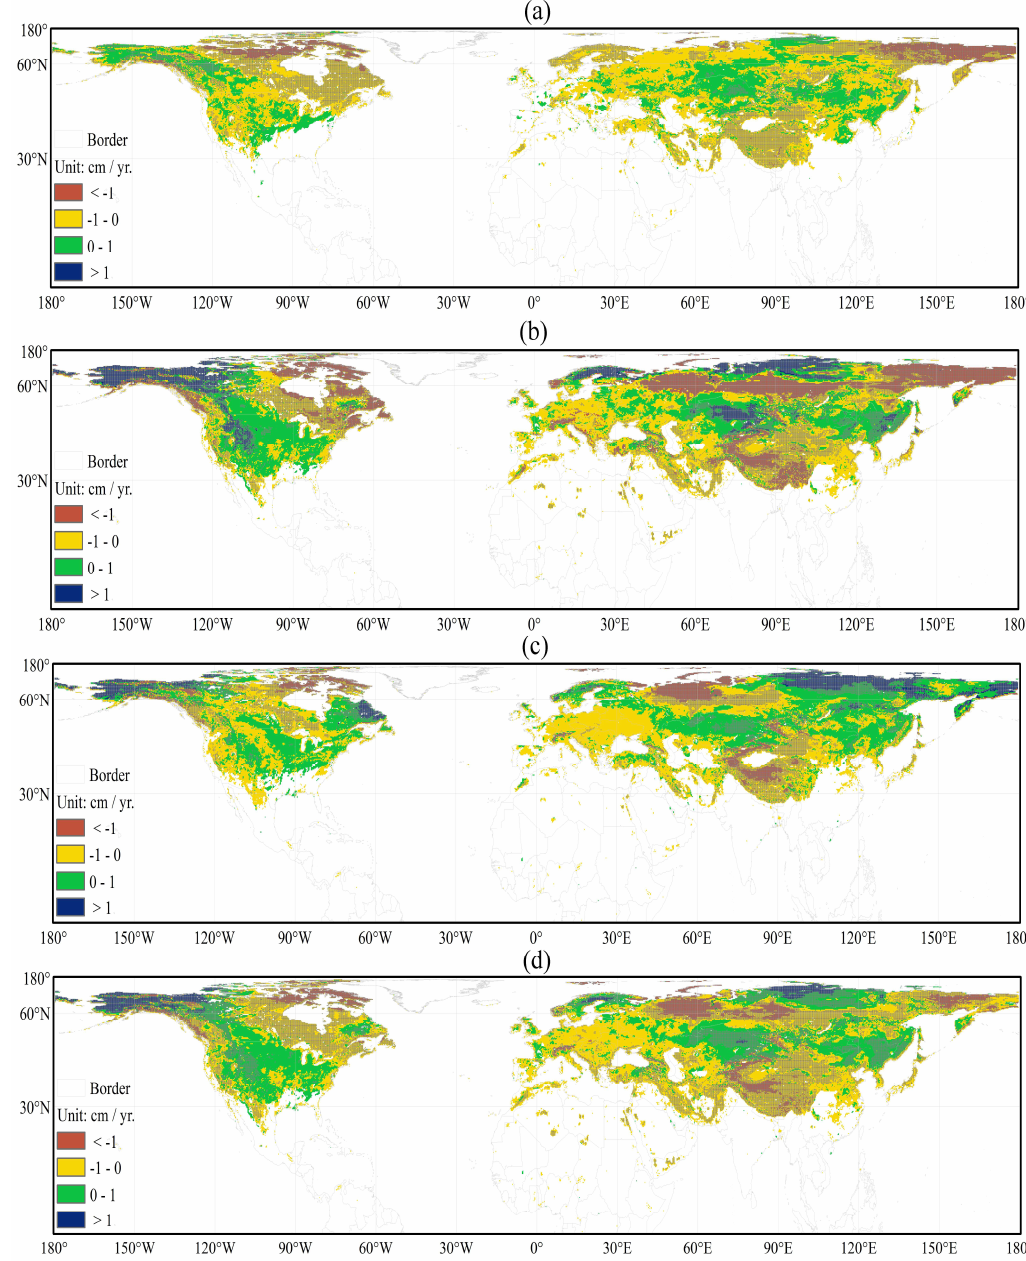
Figure A2. The variation rate pattern of annual average SD ( d ) and seasonal average SD ( a – c ) over the Northern Hemisphere for three snow cover seasons, autumn ( a ; September to November), winter ( b ; December to February), and spring ( c ; March to June) from 2002–2016. The black dots in ( a – d ) indicate that the changes are significant at a 95% confidence level (CL).